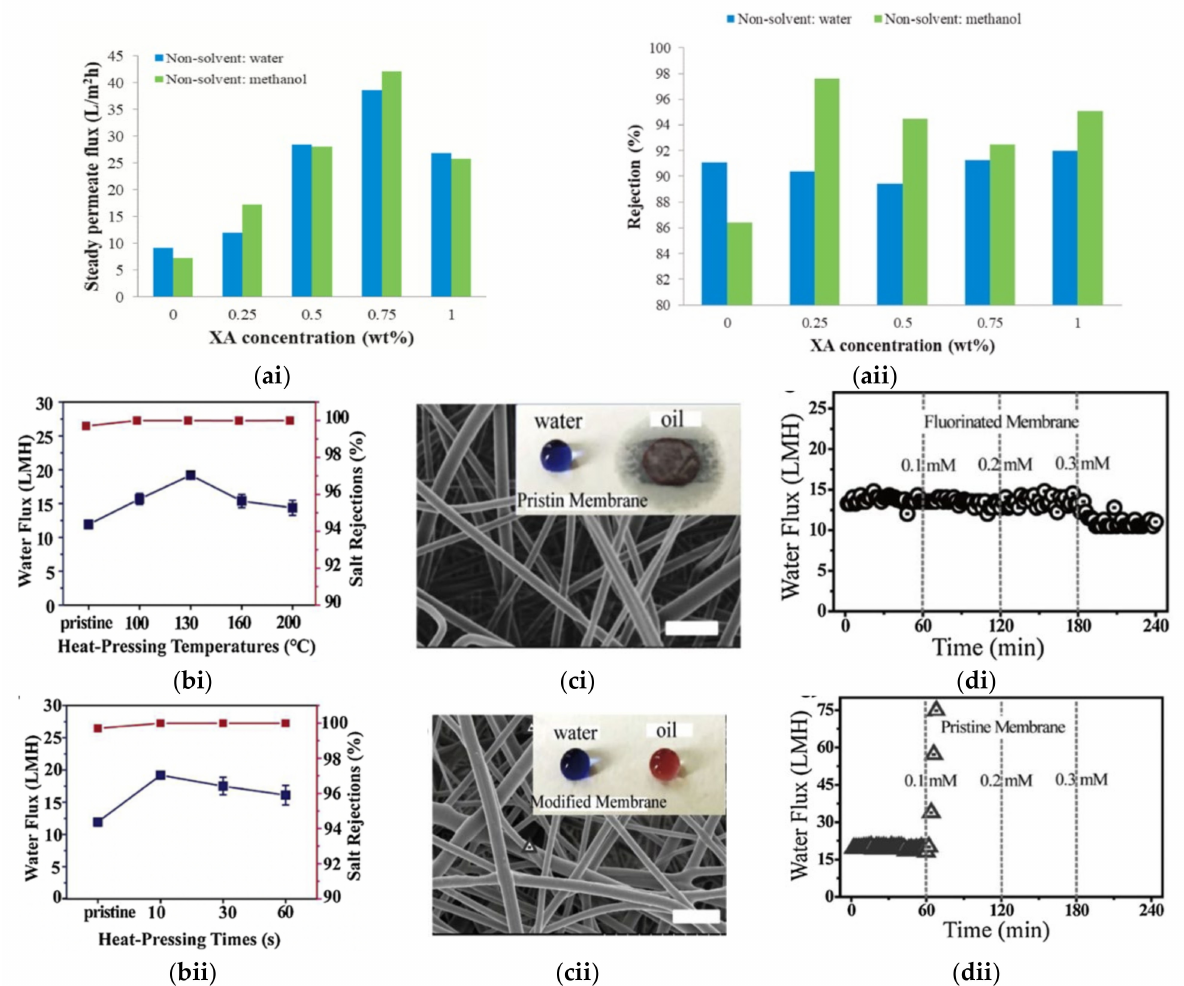
Figure 7. ( a ) (i) Steady permeate flux and (ii) diltiazem rejection of recycled PET NF membrane prepared from different concentration of XA and types of coagulants [158]. ( b ) Water flux and salt rejection of PET nanofibrous NF membrane as a function of (i) hot-pressing temperatures with duration of 10 s and (ii) hot-pressing duration at 130 ◦ C ( c ) anti-wetting ability of (i) pristine and (ii) fluorinated membranes to water and oil; ( d ) water flux of (i) pristine and (ii) fluorinated membranes as function of surfactant concentration